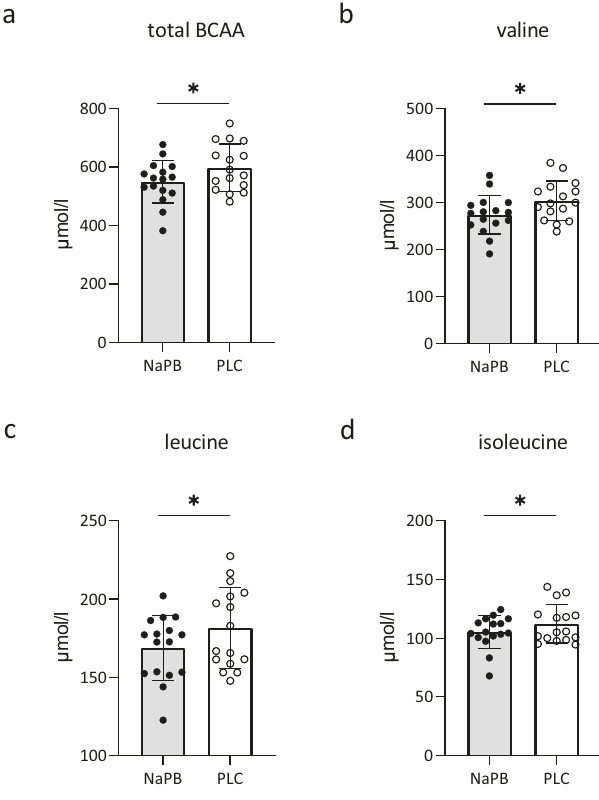
Fig. 4 NaPB treatment reduces plasma BCAA levels. Fasting plasma BCAA ’ s were measured in patients with T2D after 2-week treatment with NaPB (gray bars, n = 16) and placebo (white bars, n = 16). a Total BCAA levels ( µ mol/l, p = 0.03), b valine levels ( µ mol/l, p = 0.009) and c leucine values ( µ mol/l, p = 0.03), and d isoleucine ( µ mol/l, p = 0.05). Data are expressed as mean ± SE. The intervention effect was analyzed using the paired student t -test. * P < 0.05. NaPB sodiumphenylbutyrate, PLC placebo, T2D type 2 diabetes. Source data are provided as a Source Data fi le.